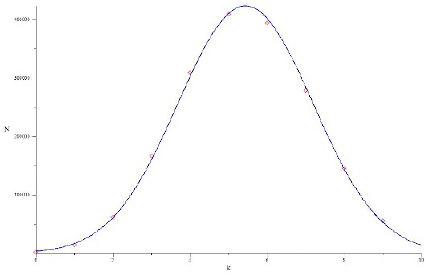
Figure 4 . Red dots are ^ N c =1 numbers, blue curve is a Gaussian distribution with parameters [1 ; 1] ; (cid:0) 7 ;k (cid:22) = 5 : 44 (cid:27) = 1 : 75 I = 1 : 85 10 6